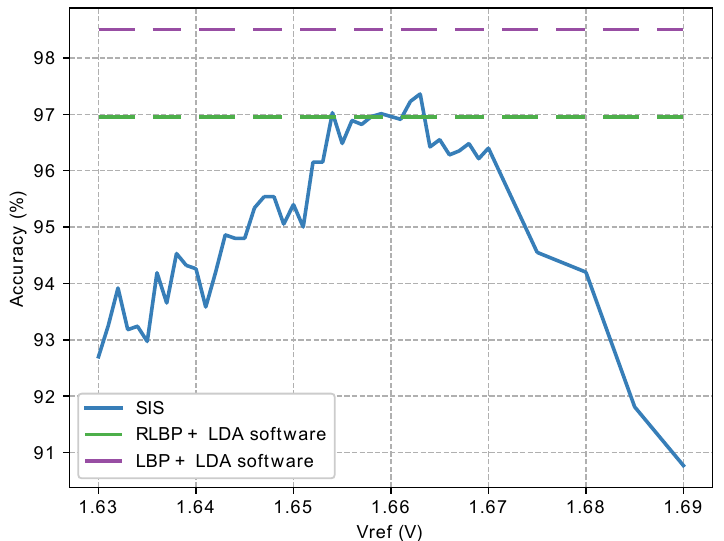
Figure 19. Classification accuracy as a function of the value of the comparator input V ref in Figure